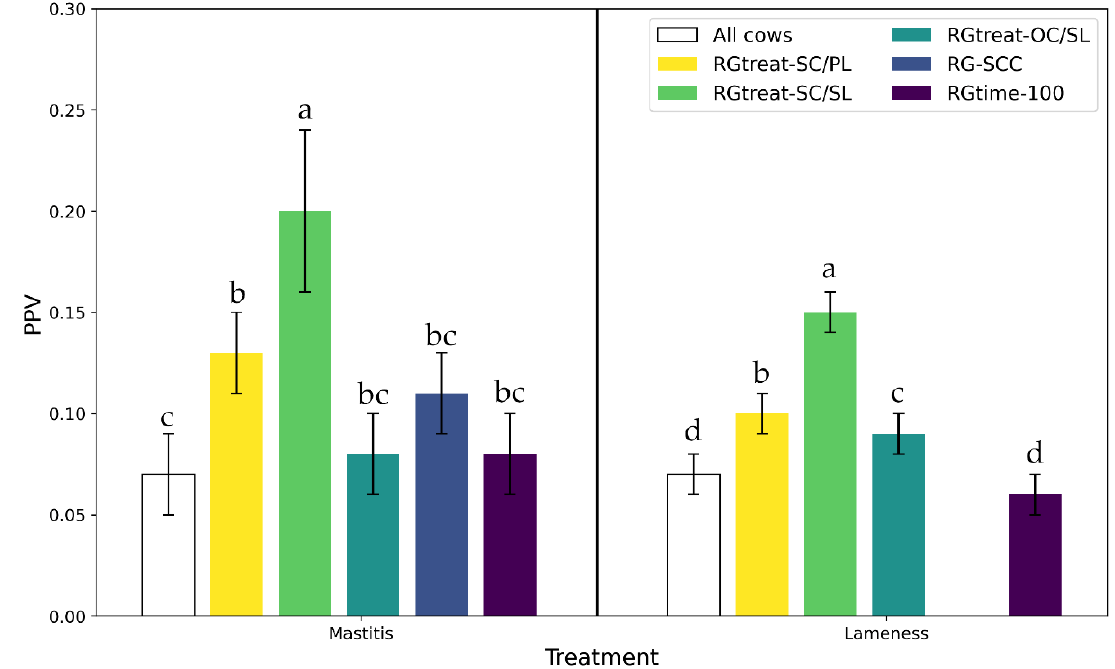
Figure 5. Mean positive predictive value (PPV) from classification results for mastitis and lameness treatments. Error bars indicate the 95%-CI, while letters a, b, c, d indicate significant differences at p ≤ 0.05 between treatment categories. RGtreat-SC/PL: at least one treatment of the same category in the previous lactation, RGtreat-SC/SL: at least one previous treatment of the same category in the same lactation, RGtreat-OC/SL: at least one previous treatment of another category in the same lactation, RG-SCC: high SCC in previous milk recording, RGtime-100: DIM ≤ 100.